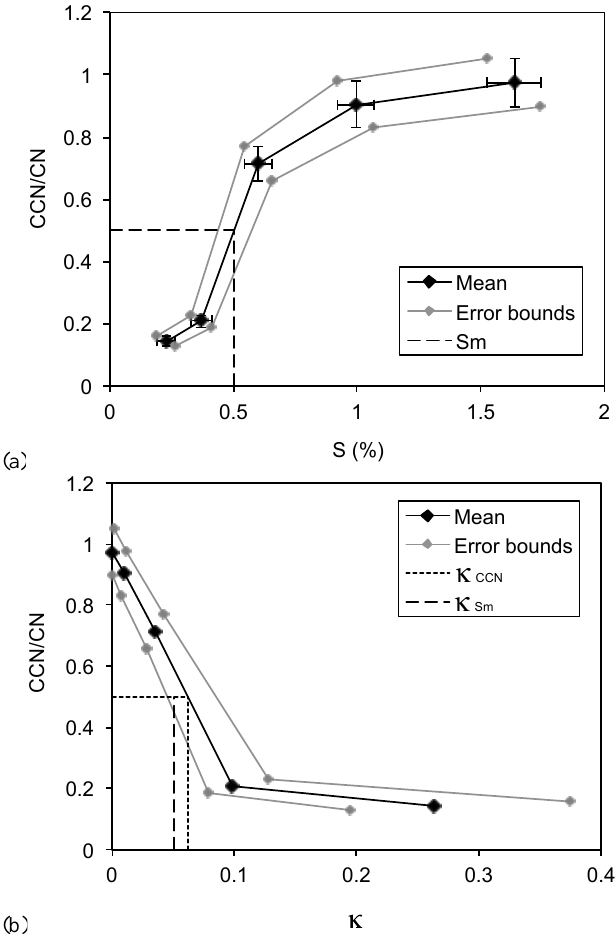
Fig. 2. The derivation of κ CCN using 100nm oak wood smoke par- ticles as an example. (a) Average CCN spectrum from experiment 14a (oak wood) including error bars indicating a measurement un- certainty of ± 1 σ are shown as a black line and black symbols, upper and lower bounds of the activation curve (see Sect. 2.4) are shown as gray lines, and the supersaturation where 50% of the particles are activated is indicated by a vertical dashed line. (b) The same CCN/CN ratios plotted as a function of κ corresponding to each S measurement point (black symbols and line) with error bounds (gray symbols and lines). κ CCN , defined as the value of κ where 50% of the particles are activated is indicated by a dotted line, and is substantially larger than κ corresponding to S m c ( κ Sm ; dashed